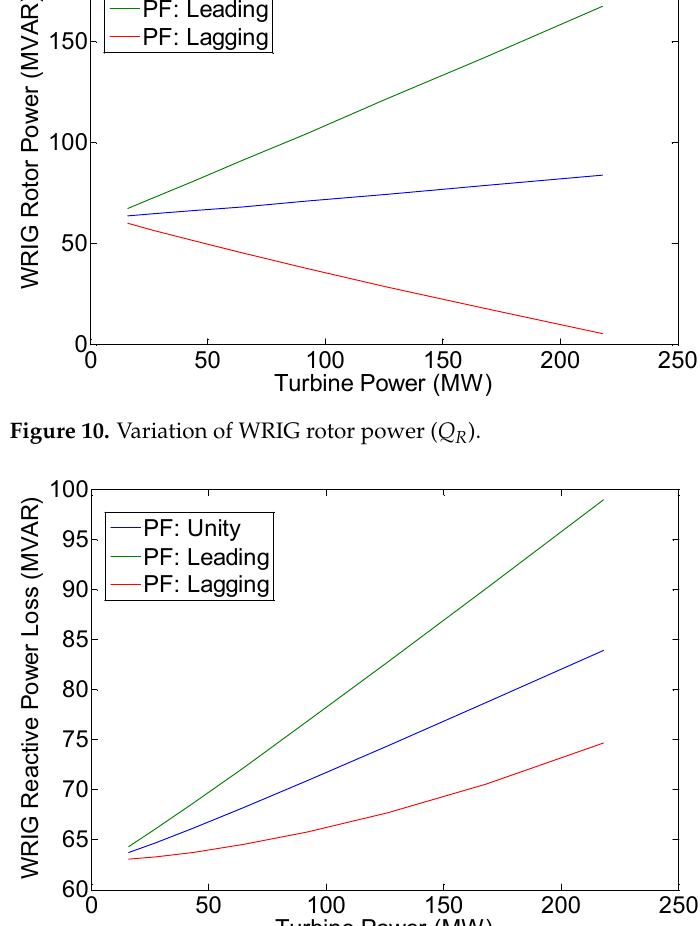
Figure 11. Variation of WRIG reactive power loss ( Q LOSS ).